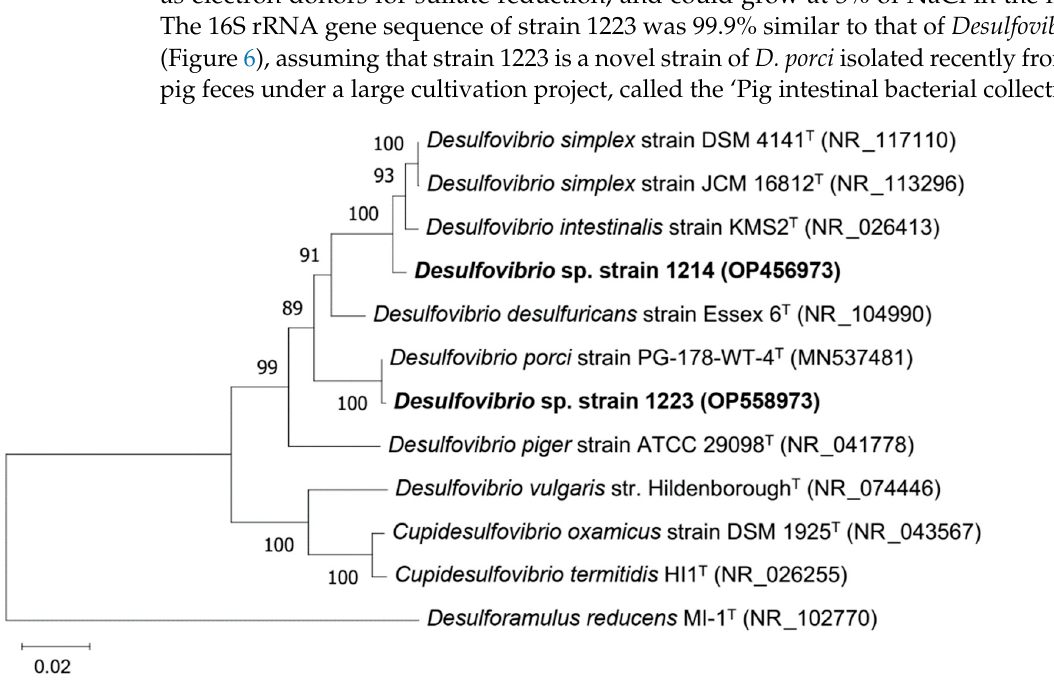
Figure 6. 16S rRNA gene-based neighbor-joining tree showing the phylogenetic position of strains 1211 and 1198. The percentage of replicate trees in which the associated taxa clustered together in the bootstrap test (1000 replicates) are shown next to the branches. The evolutionary distances were computed using the maximum composite likelihood method and are in the units of the number of base substitutions per site. All ambiguous positions were removed for each sequence pair (pairwise deletion option). There were a total of 1590 positions in the final dataset. Evolutionary analyses were conducted in MEGA11.